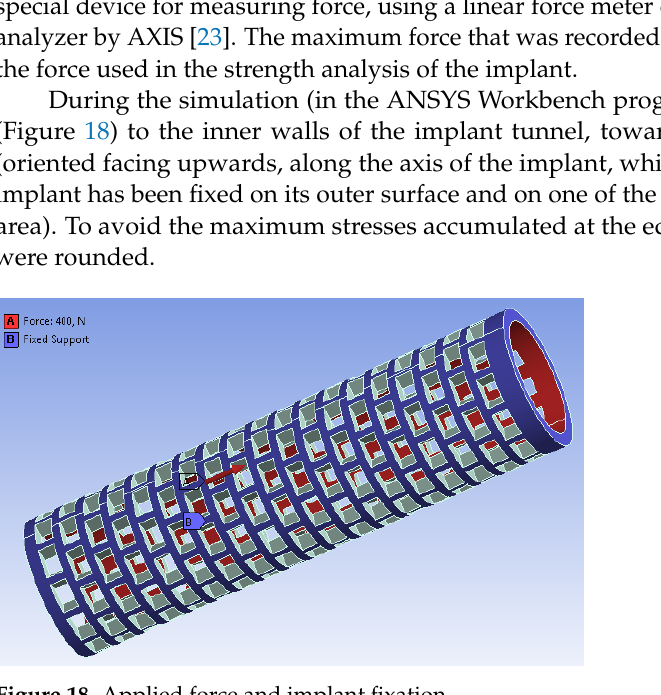
Figure 18. Applied force and implant